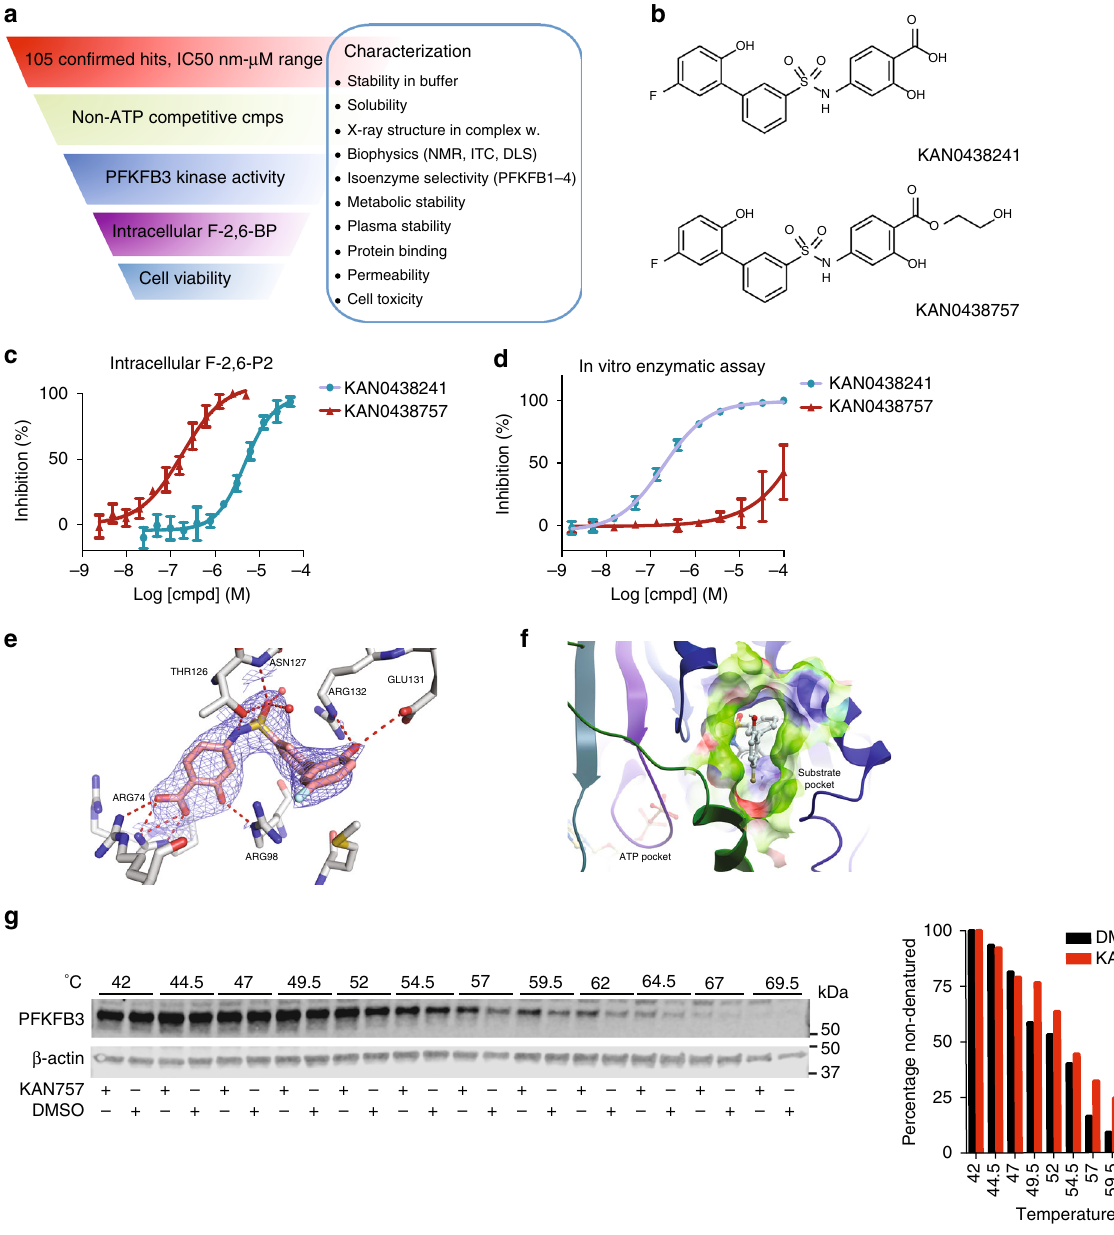
Fig. 3 Development of PFKFB3 inhibitor. a Illustrative description of the drug discovery process towards identi fi cation of KAN0438757 as a PFKFB3 inhibitor. Following measurements of inhibition of human recombinant enzyme, the inhibitory effects on PFKFB3 in cells were demonstrated by intracellular measurements of F-2,6-BP levels by the van Schaftingen assay, thereafter effects on cell viability in different cancer cells were assessed. In parallel, biophysical studies were used to validate mechanism-of-action, selectivity towards related isoenzymes was tested to ascertain a promising selectivity pro fi le, and different ADME assays were carried out to identify a molecule with promising properties. b Chemical structures of the PFKFB3 inhibitors KAN0438241 and the pro-drug KAN0438757. c Comparison of the acid KAN0438241 and its pro-drug KAN0438757 on inhibition of F-2,6-P2 level using the van Shaftingen assay in cells, n = 4. d Comparison of the acid KAN0438241 and its pro-drug KAN0438757 on inhibition of human recombinant PFKFB3 kinase activity. Activity was quanti fi ed based on the production of ADP and F-2,6-P2 from ATP and F6P, n = 5. e Stick model of KAN0438241 bound to human PFKFB3. The compound is bound to the fructose-6-phosphate substrate pocket. The stick model is colored according to atom type: oxygen in red, nitrogen in blue, sulfur in yellow, and carbon in white (protein) or pink (KAN0438241). Polar contacts between the compound and protein residues are shown as red dotted lines. The fi nal 2Fo-Fc electron density map for the compound, contoured at 1s, is shown as blue mesh. The image was prepared using PyMOL 1 . f X-ray structure of human recombinant PFKFB3 in complex with KAN0438241. Crystal structure of KAN04438241 (stickmodel, pdb code 6ETJ) in the substrate pocket of the catalytic domain of PFKFB3. The molecular surface of the pocket is depicted color coded according to the calculated electrostatic charge (positive in blue, negative in red, and neutral in green). The ATP binding site is indicated in the low left part of the picture. The image was generated using the ICM-pro software from Molsoft LLC (www.molsoft.com). g Target engagement and thermal stabilization of PFKFB3 by 10 µ M KAN757 (KAN0438757) as compared to DMSO in U2OS cells, assessed by CETSA. Band intensities were quanti fi ed using ImageJ, PFKBF3 levels were normalized against β -actin. To the right, bar graph representing the percentage of non-denatured PFKFB3 relative to DMSO at 42°C, shown is a representative experiment of n =